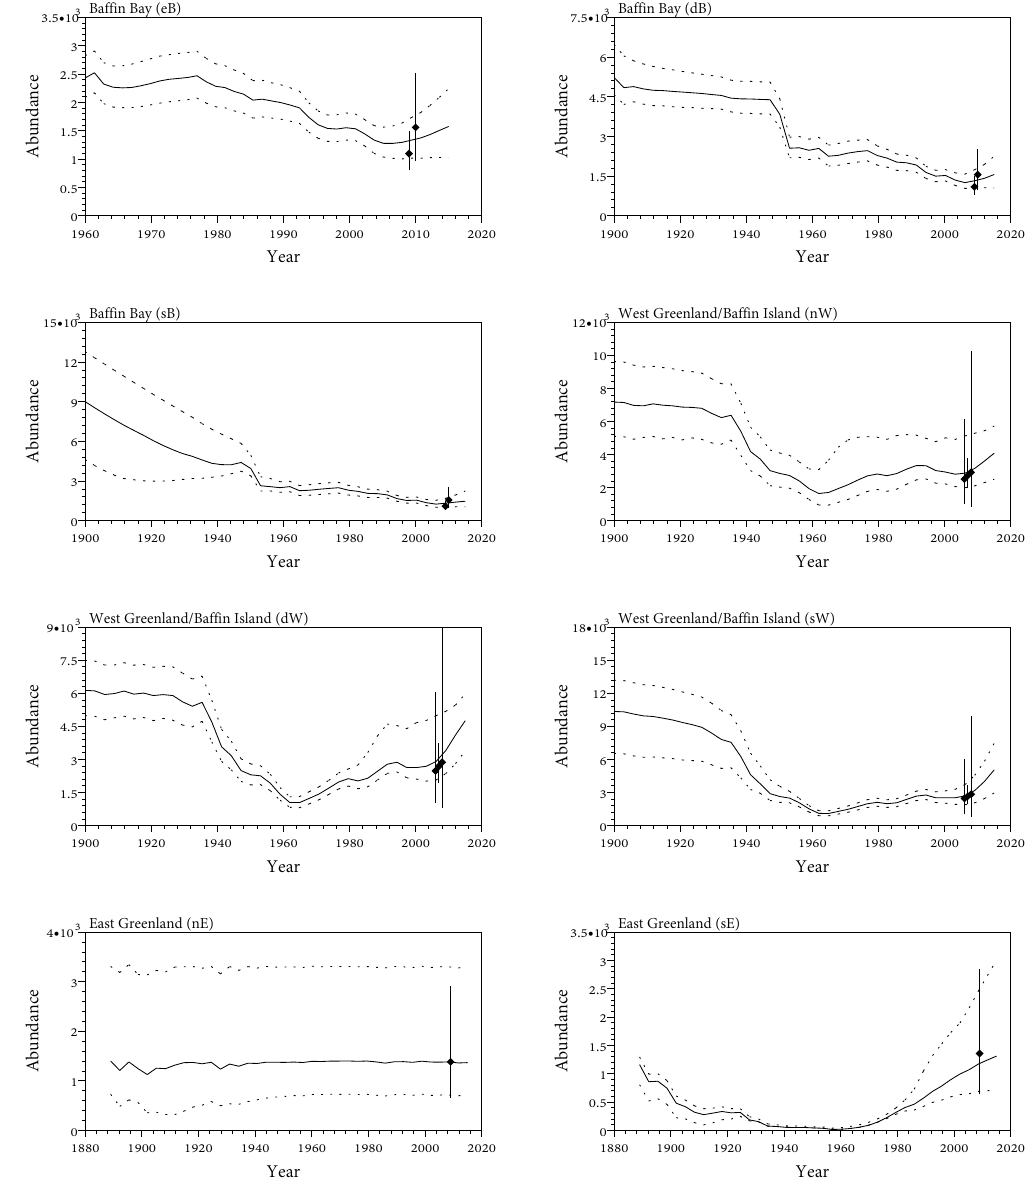
Fig. 7. The estimated population trajectories shown by the median and 95% credibility inter- vals of the different models, together with the abundance estimates and their 95% confidence intervals. eB, dB and sB are the exponential, density-regulated, and selection delayed models for Baffin Bay walruses. nW, dW and sW are the density-regulated (no age data), density-reg- ulated, and selection-delayed models for West Greenland/Baffin Island walruses. nE and sE are the density-regulated (no age data) and selection-delayed models for East Greenland wal-